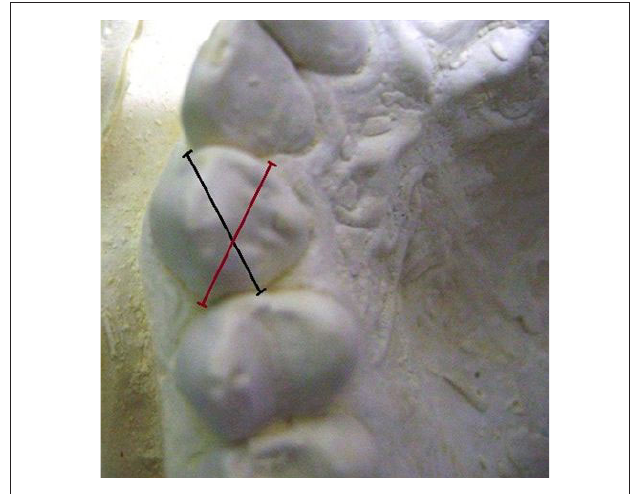
Fig. 3. Dark line indicating measurements in the MB-DL sense and red line indicating measurements in the DB-ML sense. Source: Direct